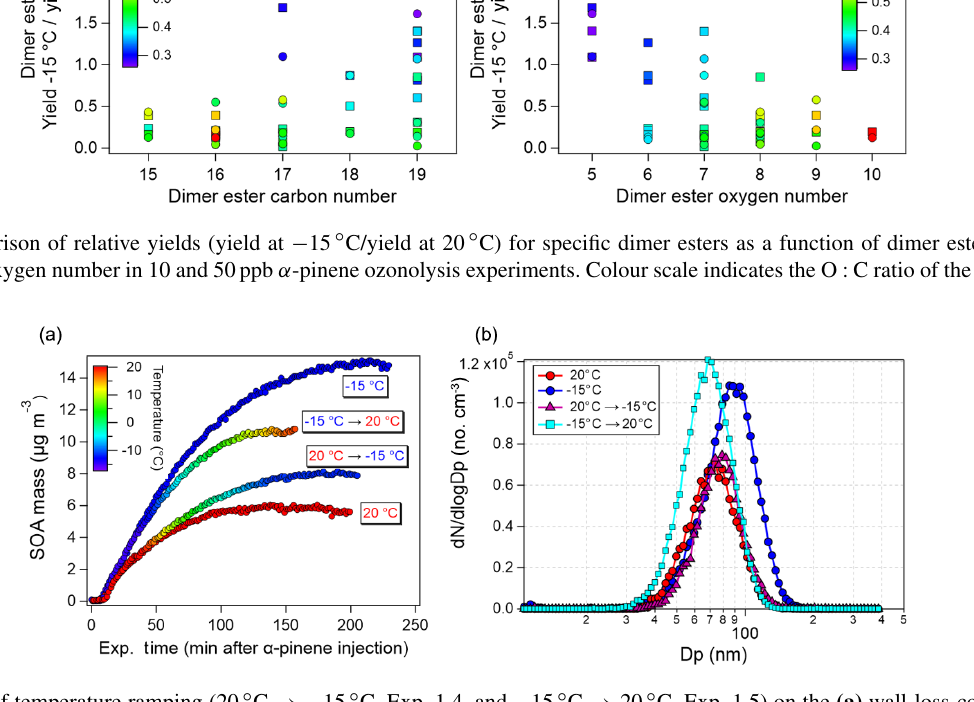
Figure 7. Effect of temperature ramping (20 ◦ C → − 15 ◦ C, Exp. 1.4, and − 15 ◦ C → 20 ◦ C, Exp. 1.5) on the (a) wall-loss-corrected SOA mass concentration and (b) final particle size distribution from ozonolysis of 10ppb α -pinene. For comparison, results from constant − 15 and 20 ◦ C temperature experiments (Exp. 1.1 and Exp. 1.3, respectively) are also